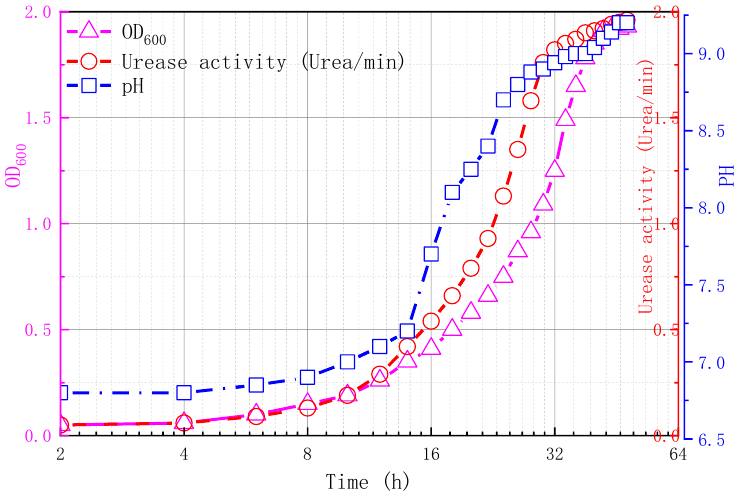
Figure 4. Changes of OD 600 , urease activity, and